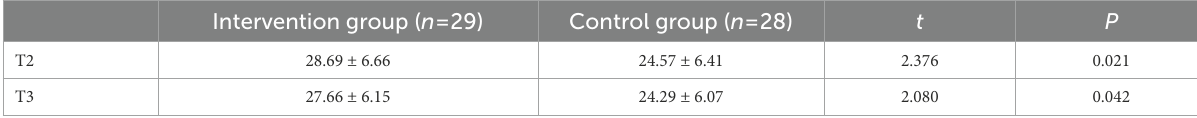
TABLE 8 Comparison of self-efficacy score among the intervention group and control group after